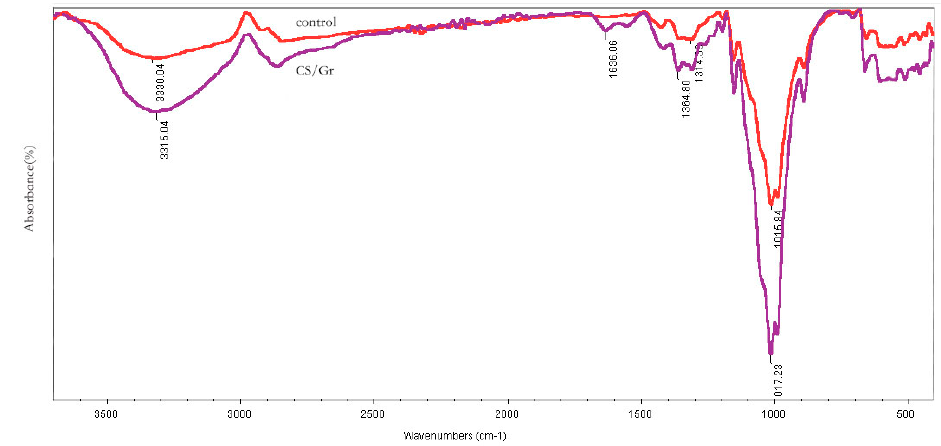
Figure 8. Infrared spectra of control and CS/Gr modified fabrics.